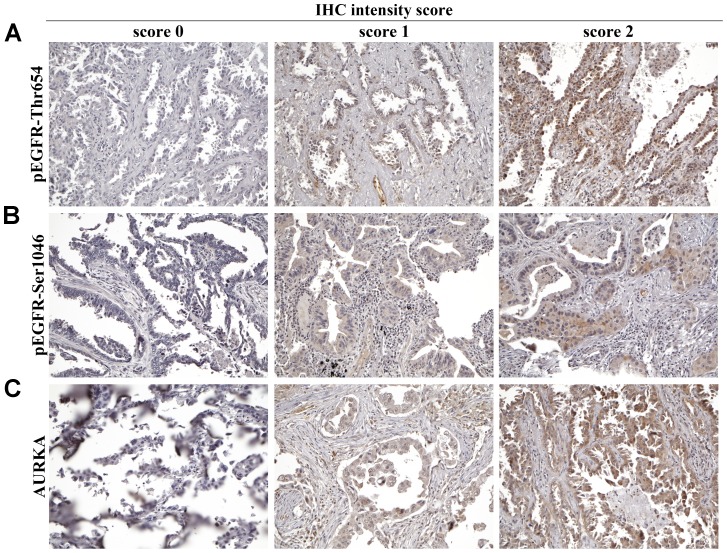
The representative expression of the IHC intensity score for AURKA, pEGFR-Thr654 and pEGFR-Ser1046 in stage I lung adenocarcinoma patients with EGFR mutations.Each column indicates a patient and each row indicates an antibody. The IHC intensity in the patients was defined as 0, 1 and 2 for AURKA, pEGFR-Thr654 and pEGFR-Ser1046 staining.